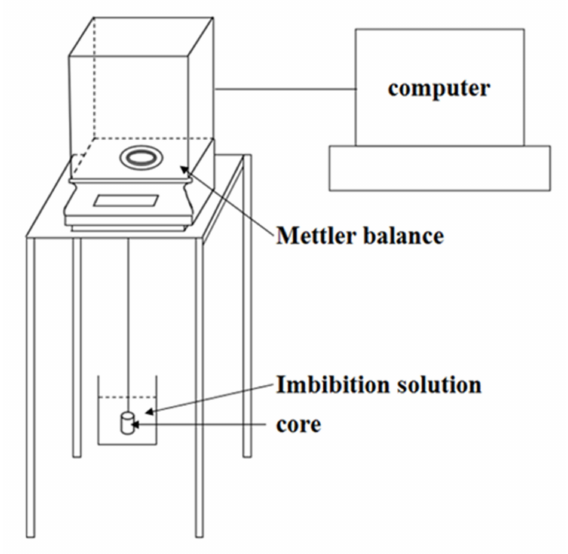
Figure 4. Self-imbibition experimental